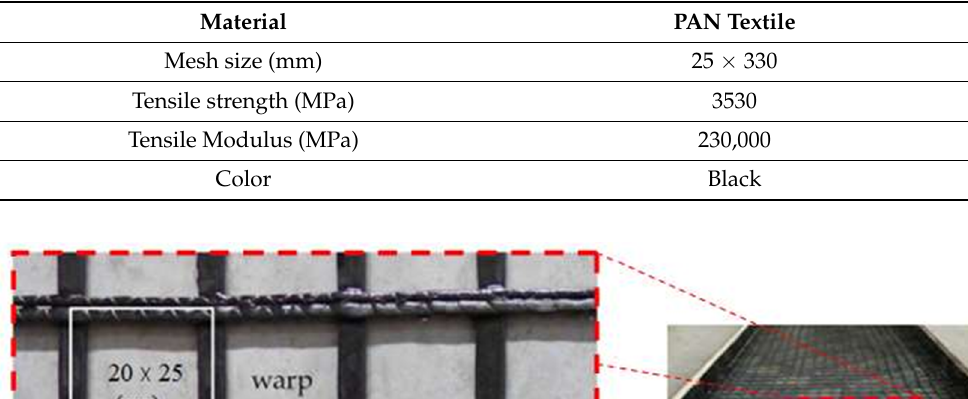
Table 4. Reinforcement details for the three slab specimens. Table 3. Cont.